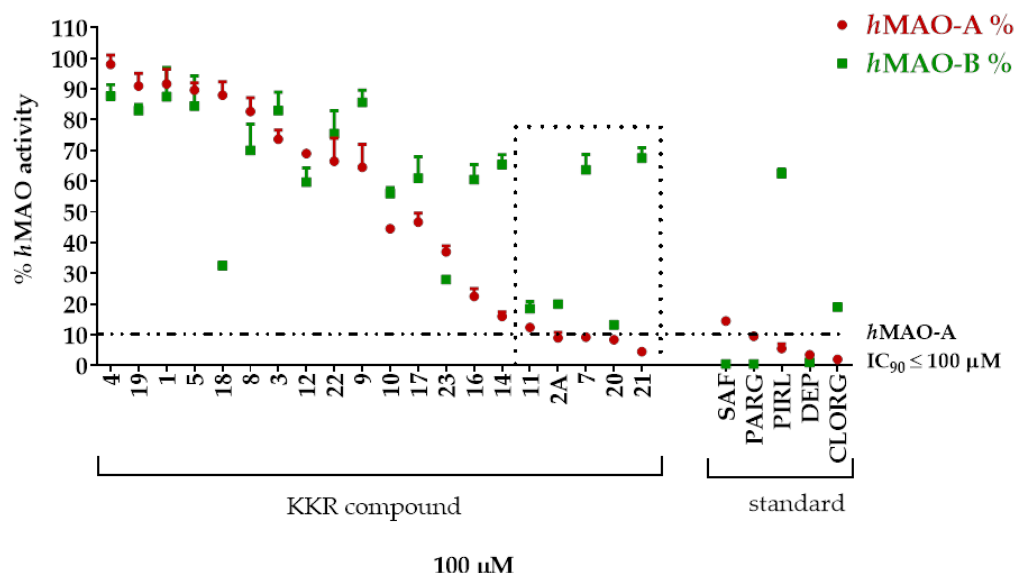
Figure 1. High throughput screening of KKR structures for top relative inhibitors of human monoamine oxidase-A ( h MAO-A) (RI A ). Synthetic compounds of 20 KKRs were tested at 100 μM for h MAO-A and h MAO-B inhibitory effects, and were compared to similar concentrations of standard MAO-AIs pirlindole (PIRL) and clorgyline (CLORG), and standard MAO-BIs safinamide (SAF), pargyline (PARG), and deprenyl (DEP). The descending order of inhibited h MAO-A activity revealed the top five active compounds (dotted rectangle) that inhibited > 90% of h MAO-A activity (dotted horizontal line).